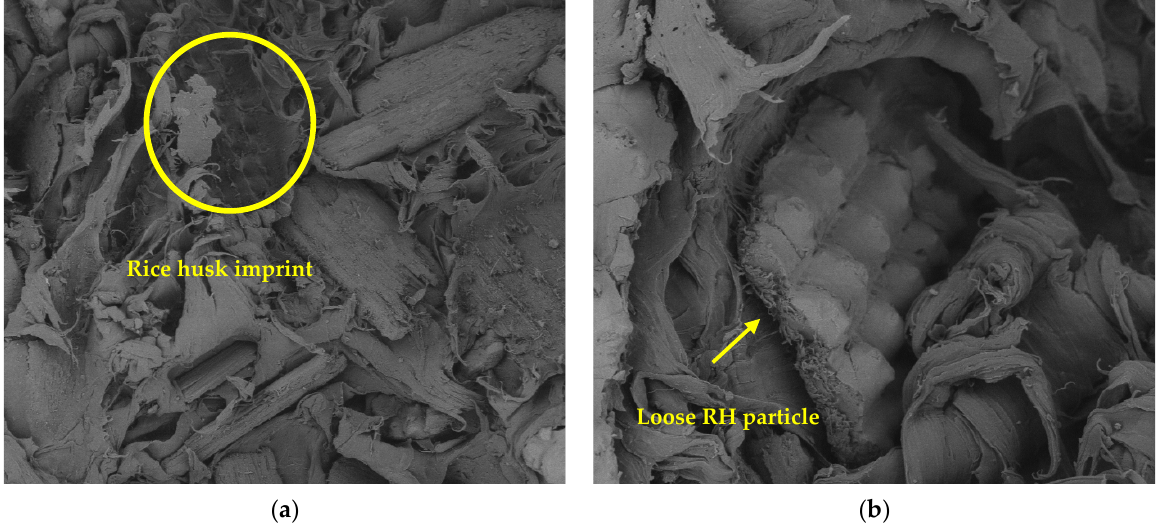
Figure 7. SEM micrographs for reinforced composite rHDPE/RH 0 ( a ) 200× and ( b ) 500× magnifica- tion.